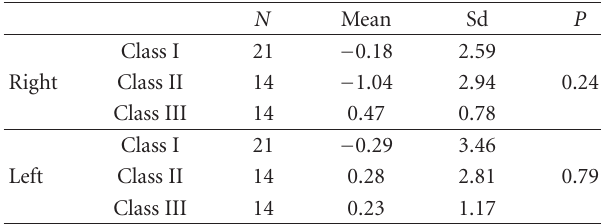
Table 3: The gonial degree changes in PR for both